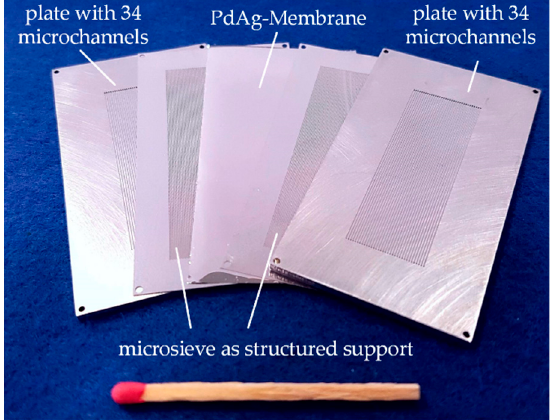
Figure 4. Structure of the microstructured membrane module. The used 5 µm PdAg membrane is mechanically stabilized by two micro sieves and integrated between two foils with micro channels. The stack is then bonded by laser welding [21].